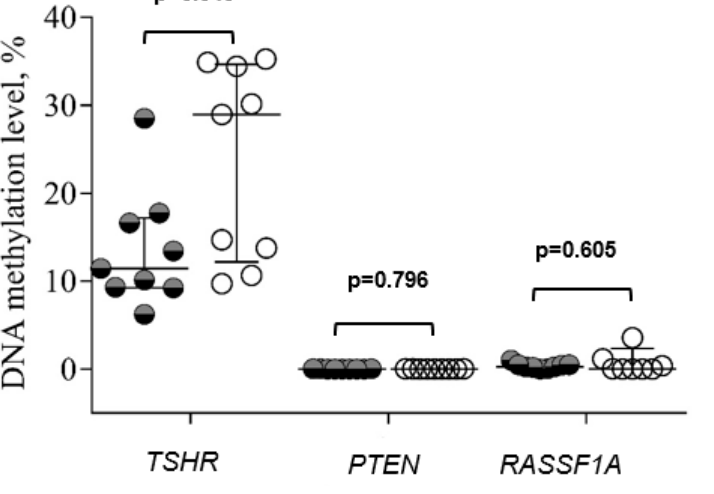
Figure 1. The comparison of TSHR, PTEN , and RASSF1A methylation levels in thyroid cancer tissue and adjacent normal tissue groups. Analysis of the Kruskal–Wallis test criterion was used to determine the differences in quantitative traits between the comparison groups. Data are expressed in whisker plots for mean and standard deviation (SD).